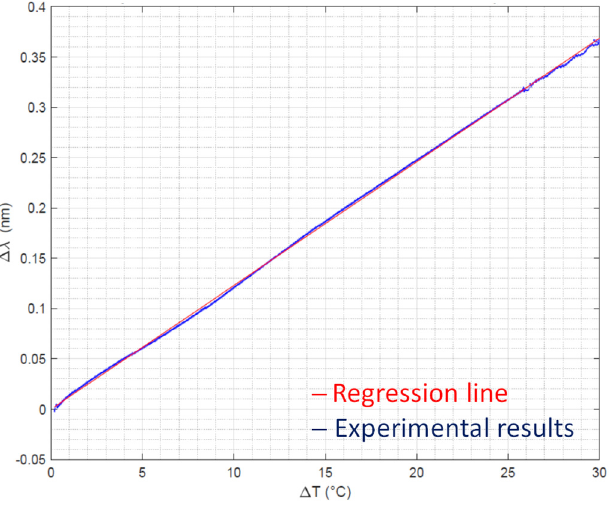
Figure 8. Characterization of the FBG sensor and comparison between mathematical approximation and experimental results.